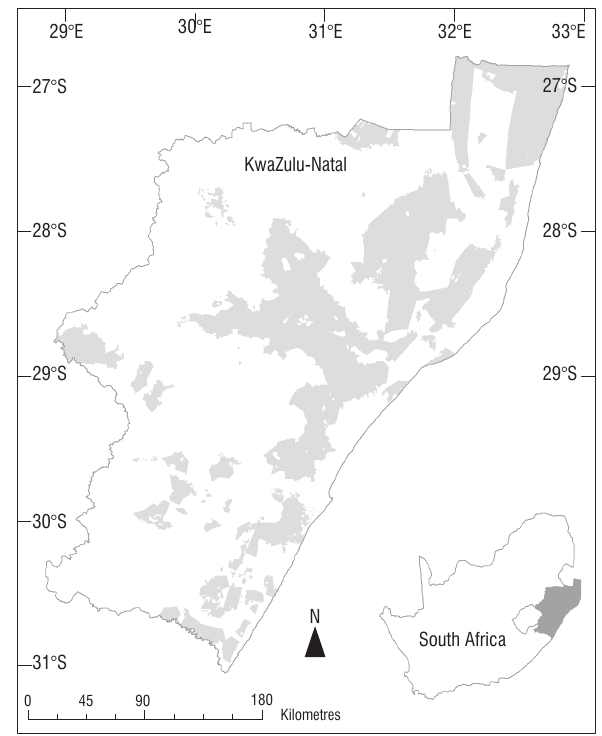
Figure 1: The location of KwaZulu-Natal, South Africa. The Ingonyama Trust Board administered areas are shown in grey, and were used as a proxy for communal areas.